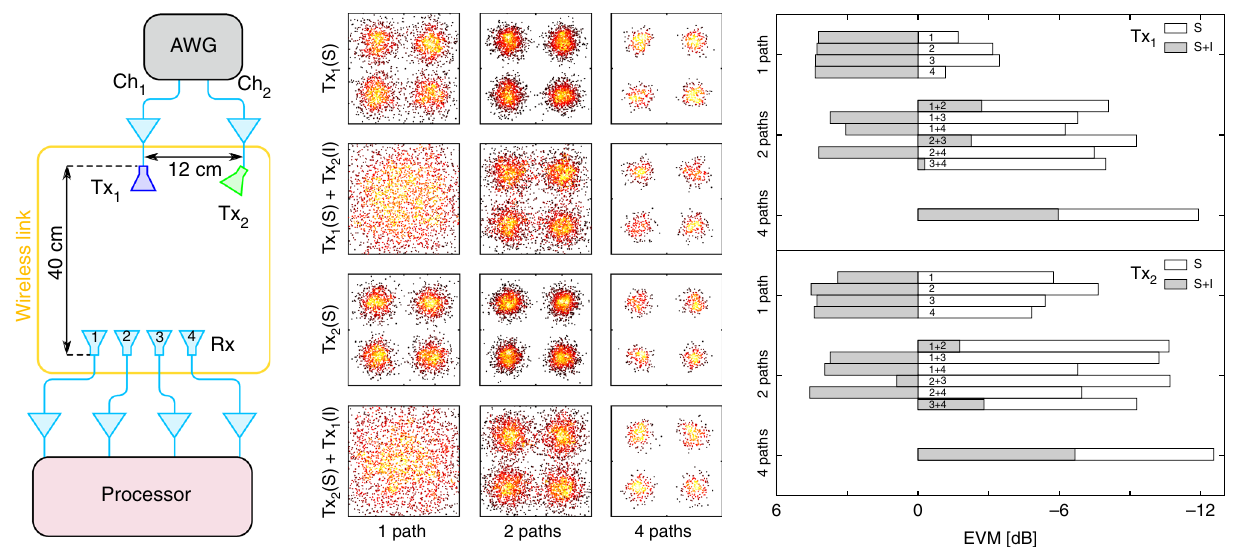
Fig. 4 Demonstration of two-beam beamforming. a Set-up. b Representative constellation diagrams of the output signal obtained when one Tx antenna transmits the signal beam ( S ) and the other the interfering beam ( I ). c Error vector magnitude (EVM) of the output signal for different combinations of enabled paths and beams. All tests were made without introducing extra